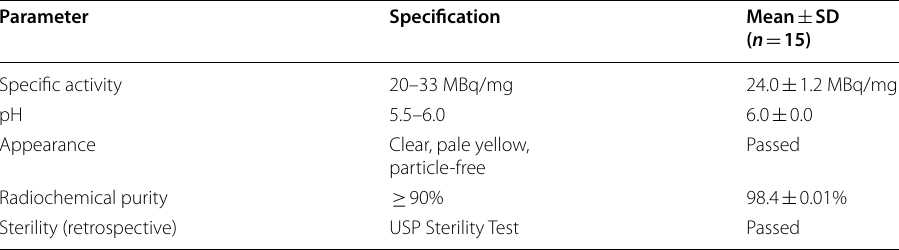
Table 3 Quality testing results for 15 sequential lots of 111 In[In]-BnDTPA-trastuzumab-NLS injection